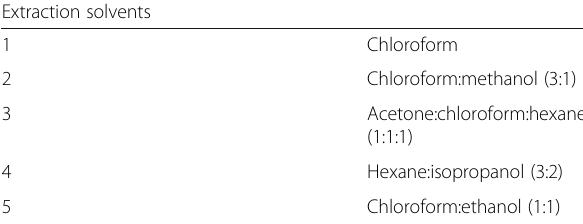
Table 2 Five extraction